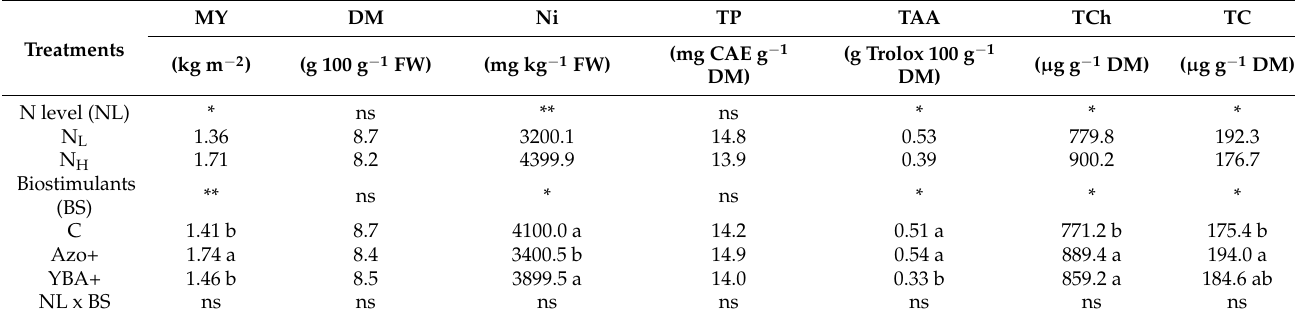
Table 2. Effects of N level (NL) and biostimulant (BS) (Azoxystrobin, Azo+; extracts of yeast and brown algae, YBA+) application on marketable yield (MY), leaf dry matter (DM), nitrate (Ni), total phenols (TP), total antioxidant activity (TAA), total chlorophyll (TCh) and total carotenoids (TC) of wild rocket at harvest time. C = control without biostimulant, Azo+ = with Azoxystrobin; YBA+ = with extracts of yeast and brown algae; N L = 32 kg ha − 1 of N, N H = 112 kg ha − 1 of N; FW = fresh